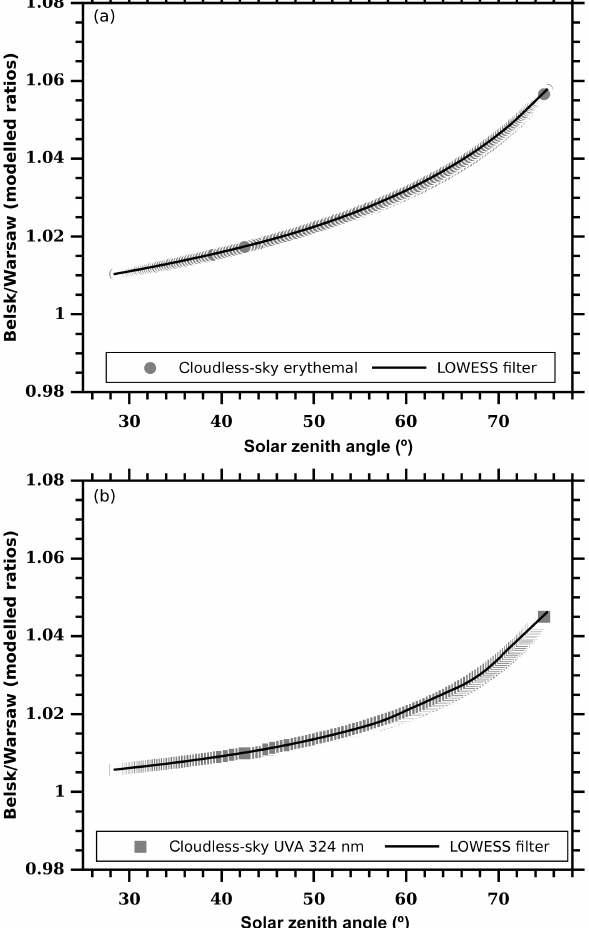
Figure 6. The Belsk / Warsaw ratio between erythemal (a) and UVA (324nm) (b) irradiances calculated by the libRadtran model for 2015 vs. SZA at Belsk for the 10:40 (GMT). The solid curve represents the data smoothed by the LOWESS